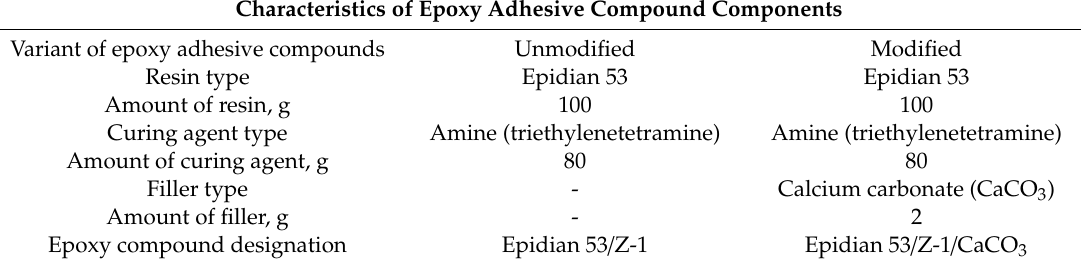
Table 3. Tested epoxy adhesive